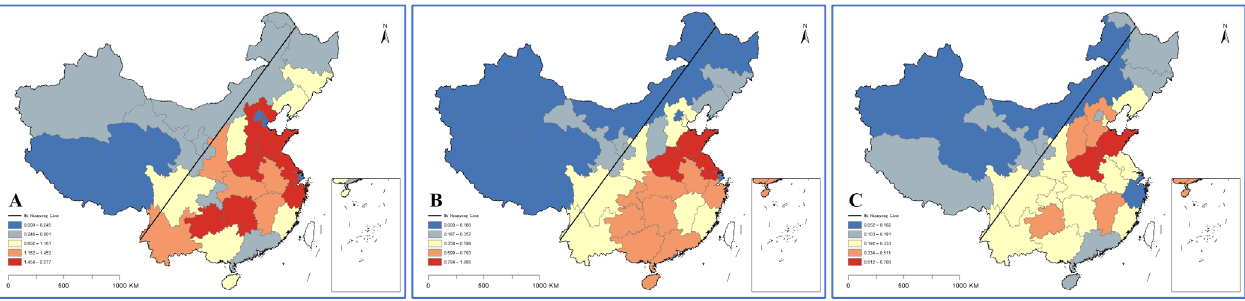
Figure 6. HRDI distribution map of personnel in 2020 (( A ) for county and county-level city medical and health institutions; ( B ) for township hospitals; and ( C ) for village clinics).